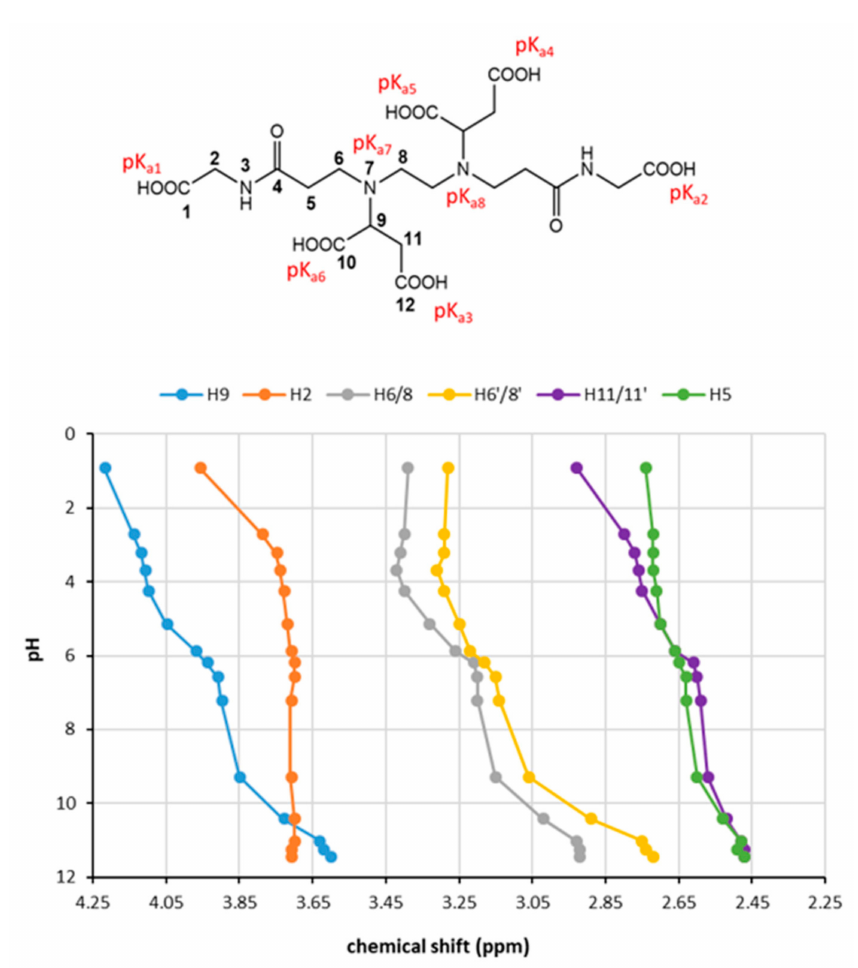
Figure 5. 1 H NMR titration of Agly-EDDS together with a tentative attribution of the pK a to the acid